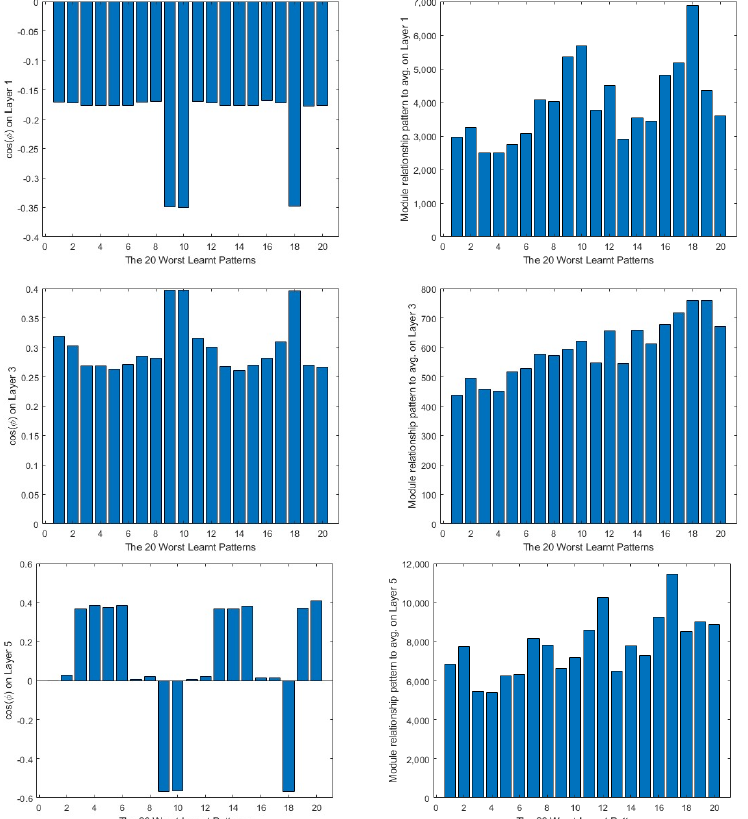
Figure 9. 20 worst learnt patterns cos( φ ) in the first column and (cid:4698) (cid:3105)(cid:3013)(cid:3042)(cid:3046)(cid:3046)